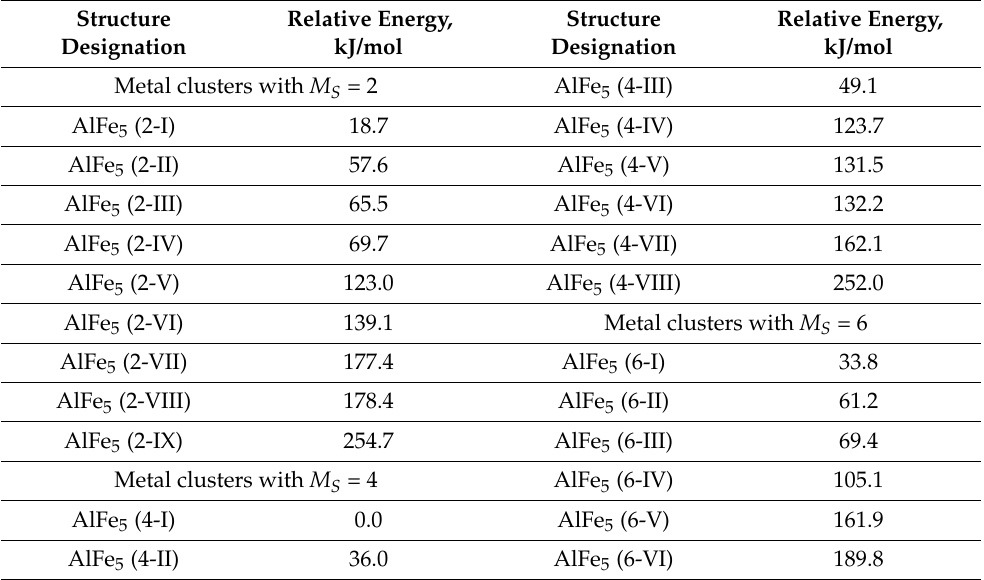
Table 9. Relative energies and spin multiplicities of the ground states of various structural isomers of metal clusters of AlFe 5 .